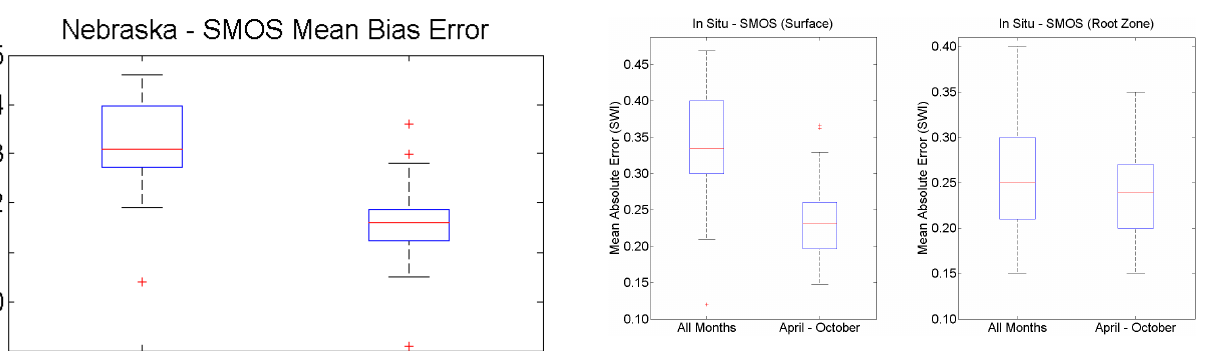
Figure 17 . Boxplots show mean absolute error calculated from (left) surface SWI and (right) root zone SWI datasets. The left boxplot in each panel show MAE calculated over all months, while the right box plots in both panels show MAE calculated only during snow-free periods.